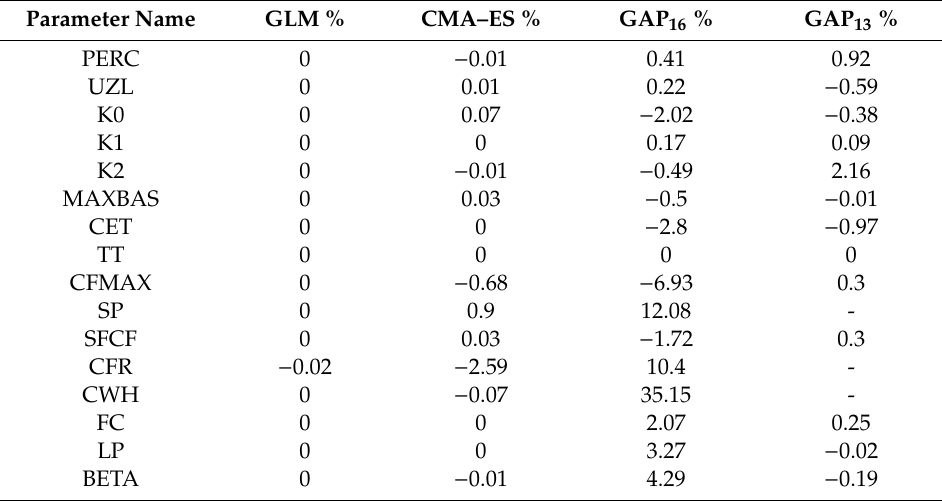
Table 6. Parameter relative deviation to “perfect fit” in the calibration procedure.